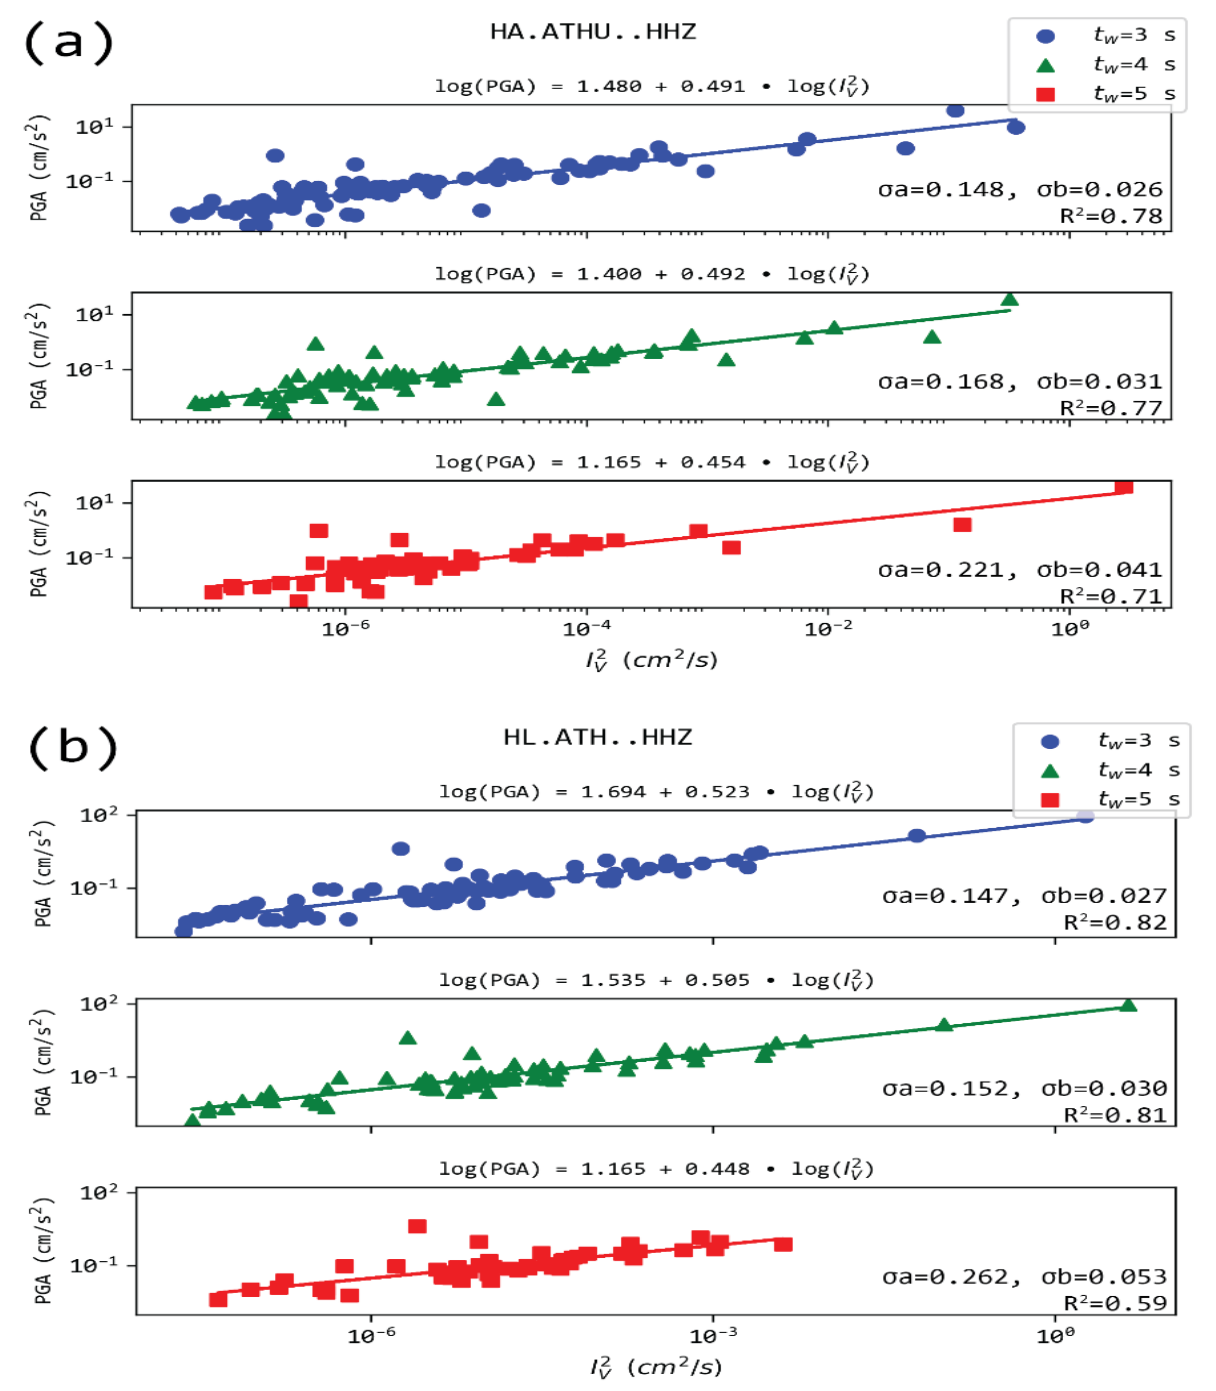
Figure 8. Regression models of PGA and I 2 for the two stations located in Athens, i.e., ATHU ( a ) and ATH ( b ), for the three time-windows (t w ) after the P arrival. The rest of the notation as in Figure 3.